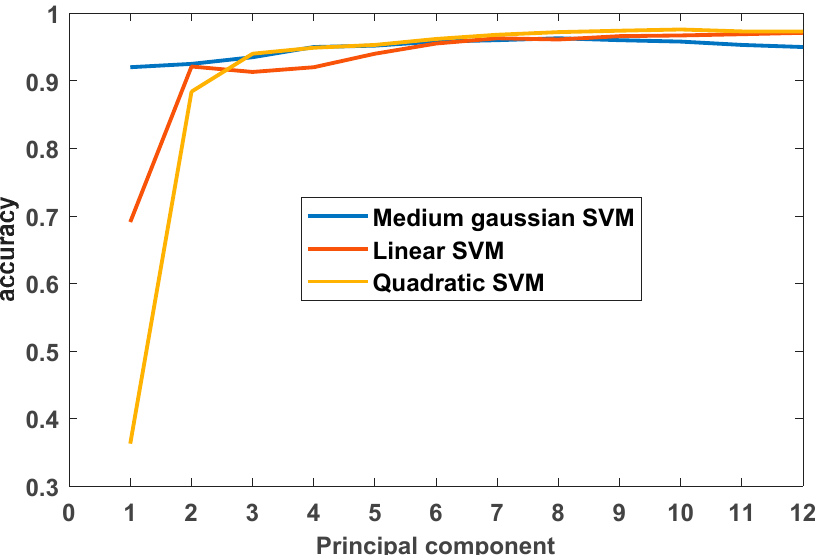
Figure 11. The influence of the number of PCA selections on the prediction accuracy of SVM model.